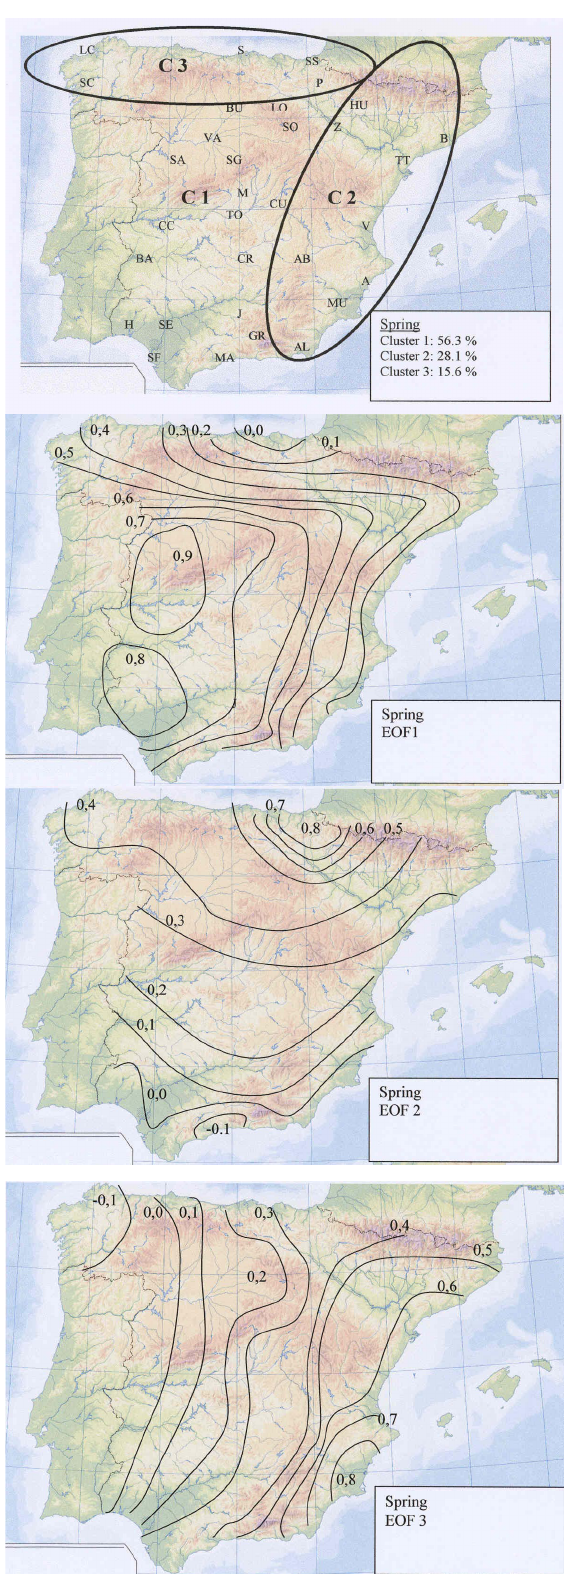
Fig. 7. As Fig. 6, for